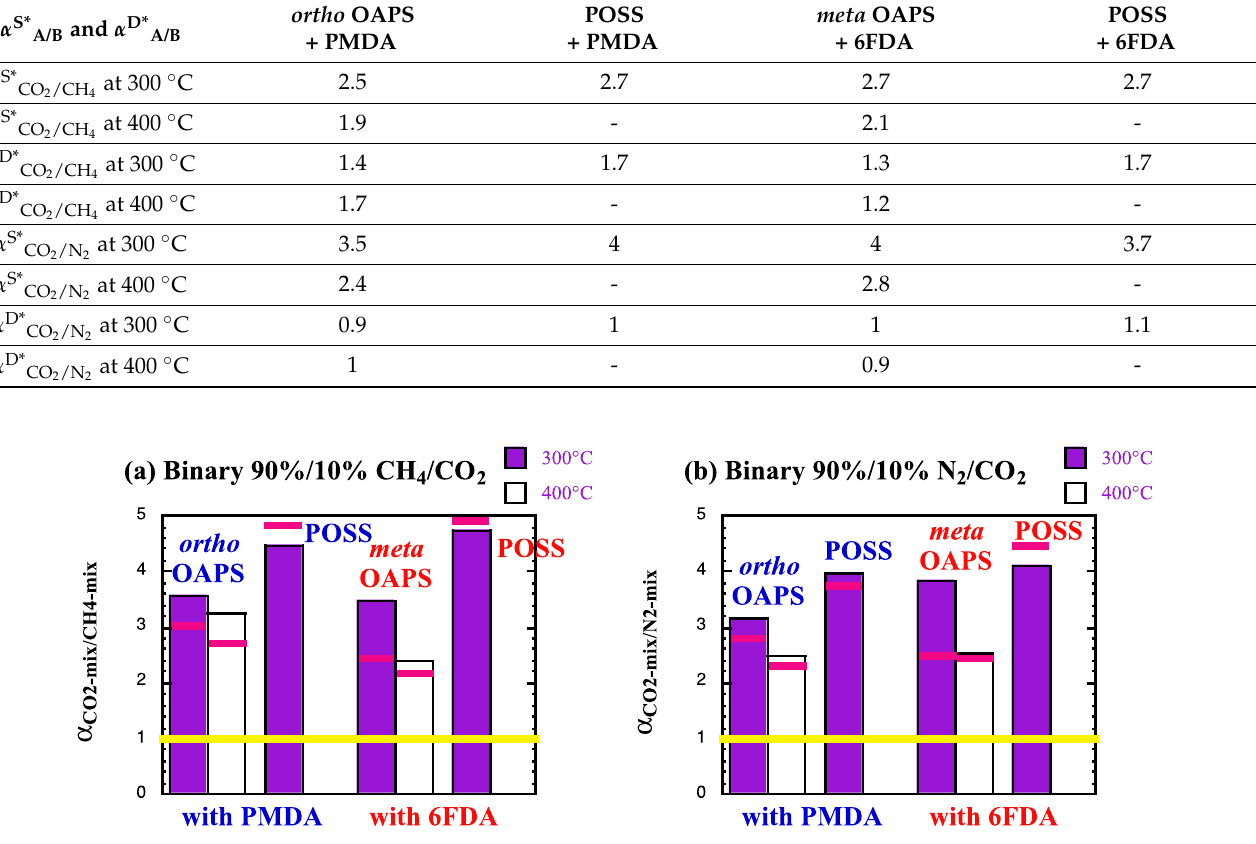
Figure 13. Real ( a ) CO 2 /CH 4 and ( b ) CO 2 /N 2 separation factors at 300 °C and 400 °C in the selected polyOAPS/POSS-imides for the CH 4 /CO 2 and N 2 /CO 2 gas mixtures at 60 bar. The maximum standard error is 0.4. The yellow lines indicate a α * A/B of 1 and the pink lines show the ideal permselectivity for each specific network.